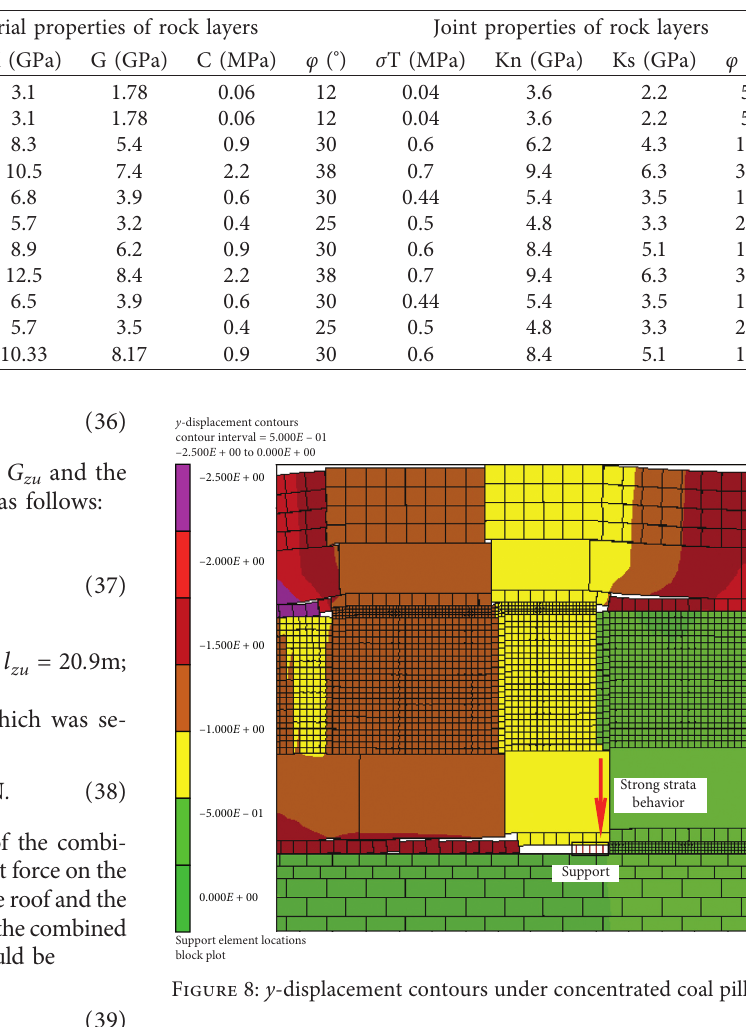
Table 1: Rock mechanical parameters in numerical simulation.